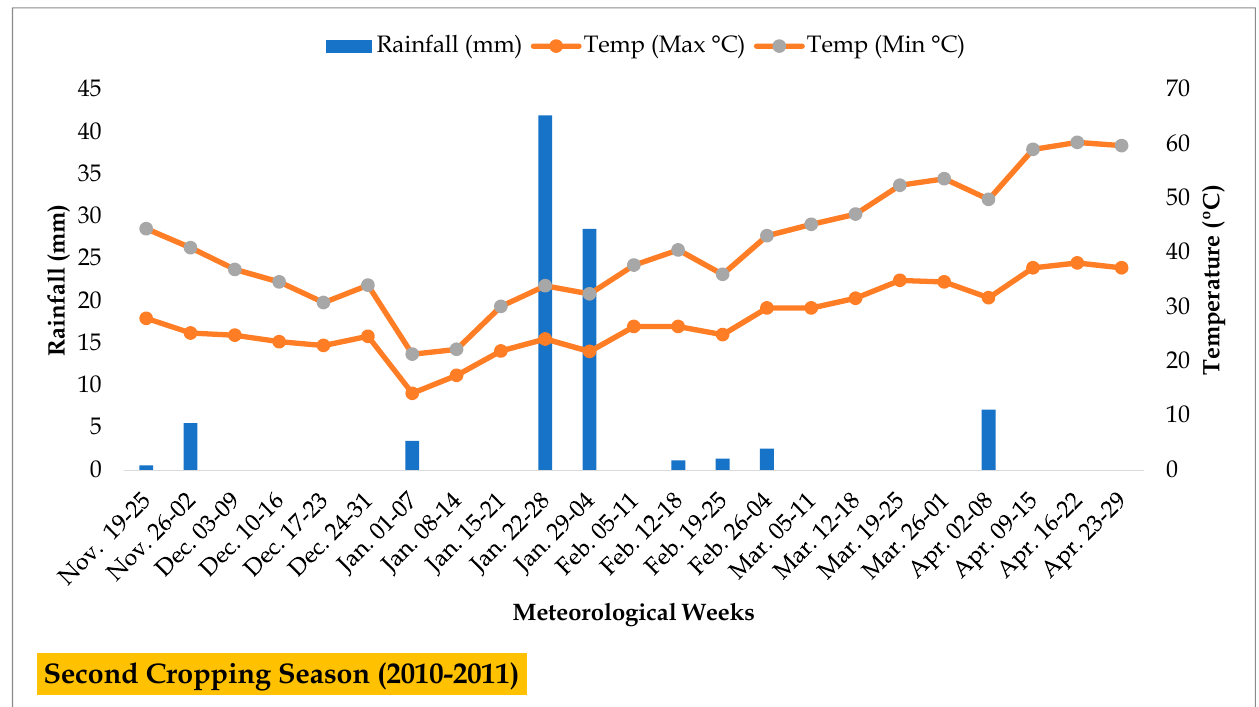
Figure 3. Climatic conditions during the second cropping season (Rabi 2010–2011).